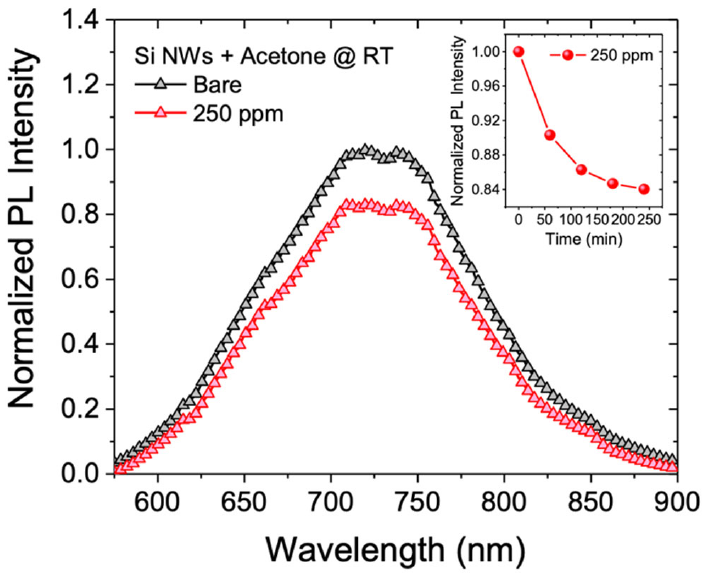
Figure 3. Normalized photoluminescent spectra at RT of the Si NWs sensor exposed to a 350 cc/min of N 2 flow (black line) and 250 ppm of acetone (red line). The inset reports the sensor quenching kinetics.